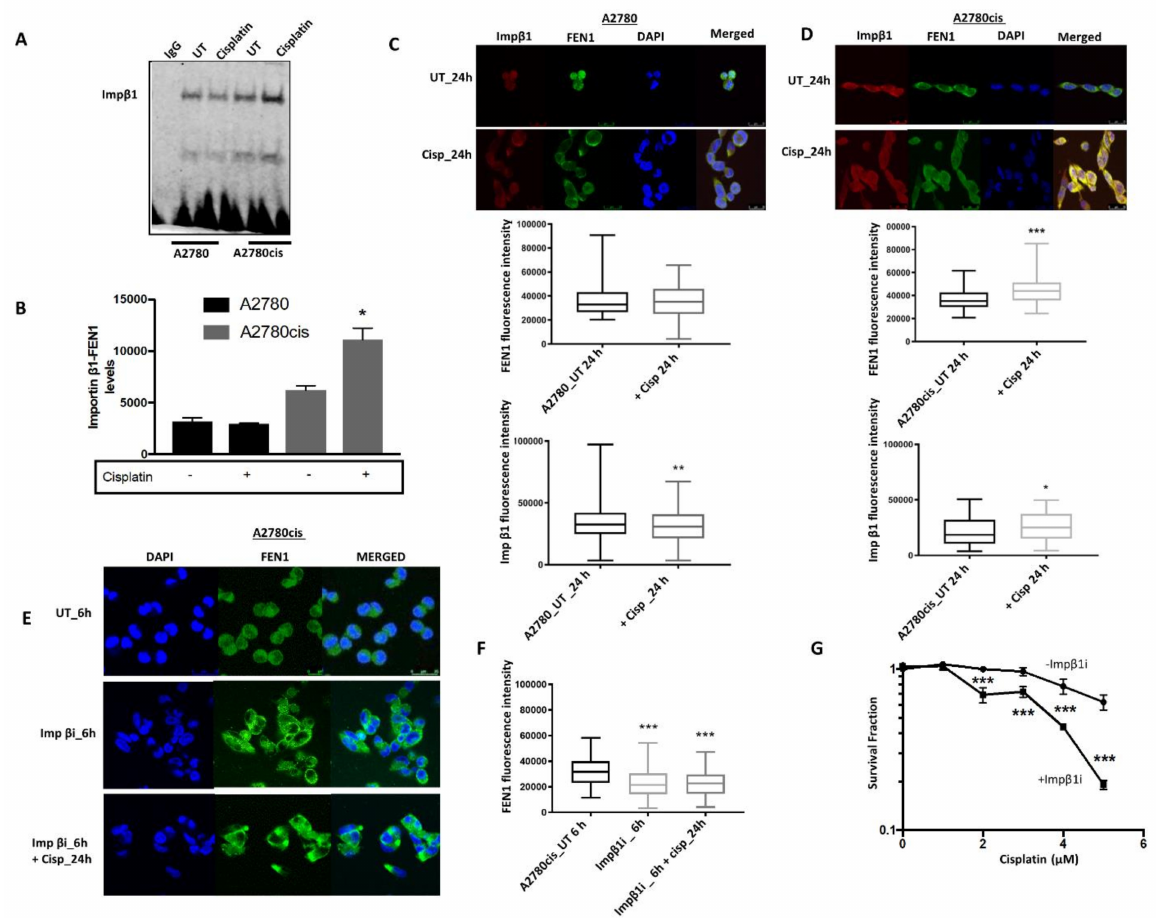
Figure 2. ( A ) Co-IP showing the physical interaction between FEN1 and importin β . The lysate was initially pulled down using FEN1 antibody and later importin β detected using western blots. See methods for details. ( B ) Quantification of FEN1-importin β protein expression. ( C ) Con-focal microscopy showing FEN1 and importin β expression following cisplatin treatment at 24 h and 48 h in A2780 cells. Quantification of FEN1 nuclear fluorescence performed using ImageJ software. ( D ) Con-focal microscopy showing FEN1 and importin β expression following cisplatin treatment at 24 h and 48 h in A2780cis cells. Quantification of FEN1 nuclear fluorescence performed using ImageJ software. ( E ) Con-focal microscopy showing FEN1 and importin β expression following importin β inhibitor for 6 h followed by cisplatin treatment at 6 h, 24 h, and 48 h. ( F ) Quantification of FEN1 nuclear fluorescence by ImageJ software following importin β inhibitor for 6 h followed by cisplatin treatment at 6 h, 24 h, and 48 h. ( G ) Clonogenic assay showing platinum re-sensitization in A2780cis cells treated with importin β inhibitor and cisplatin compared to cisplatin only. All figures are representative of 3 or more experiments. * = p value < 0.05, ** = p value < 0.01, *** = p value <